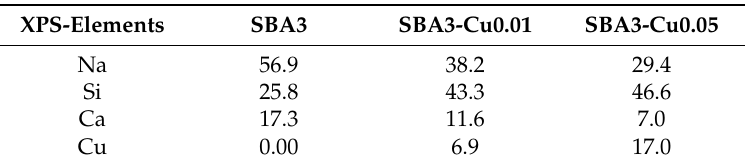
Table 4. Atomic percentages of elements obtained from XPS analyses of SBA3, SBA3-Cu0.01 and SBA3-Cu0.05. XPS-Elements SBA3